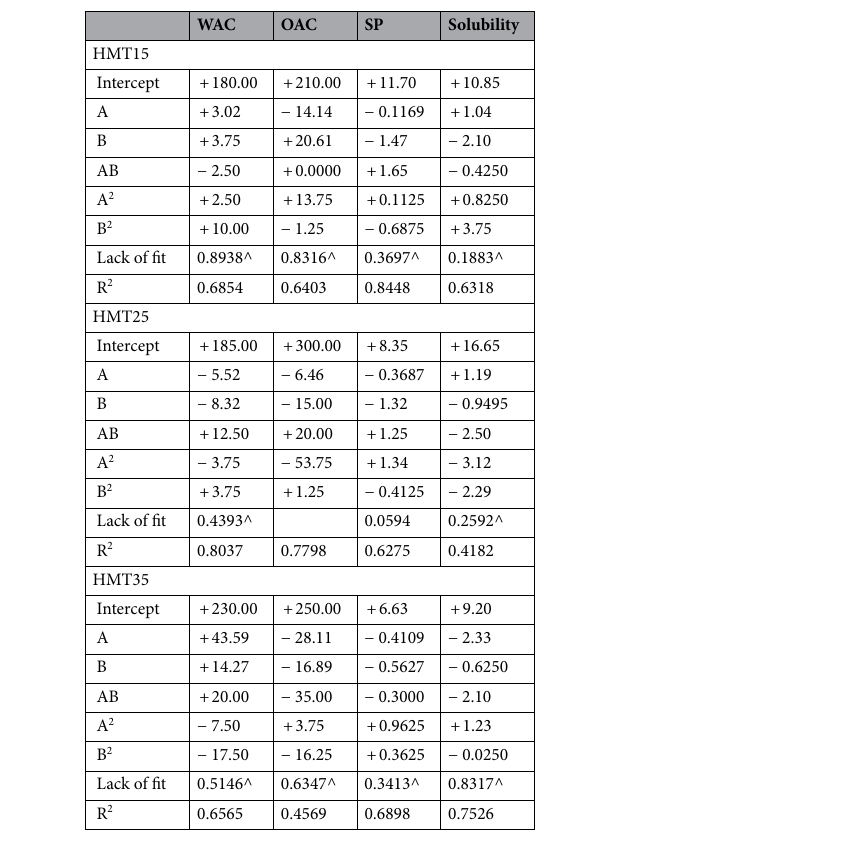
Table 6. Regression models relating functional properties and model parameters of heat-moisture treated Bambara groundnut starch. A: linear effect of treatment temperature ; B: linear effect of treatment time ; AB: interaction of temperature and treatment time ; A 2 : quadratic effect of treatment temperature ; B 2 : quadratic effect of treatment time; WAC: water absorption capacity; OAC: oil absorption capacity; SP: swelling power. ^ Not significant at p ≥